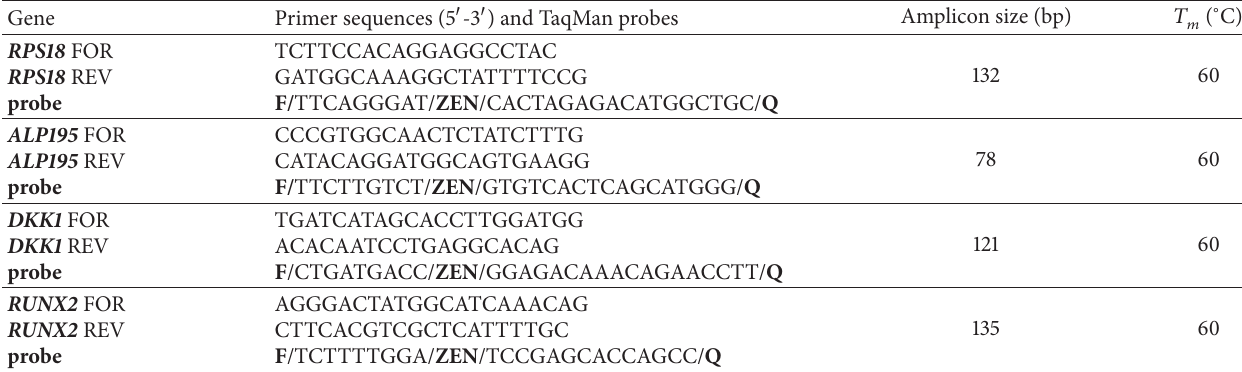
Table 3: Primers and TaqMan probes used for qRT-PCR.